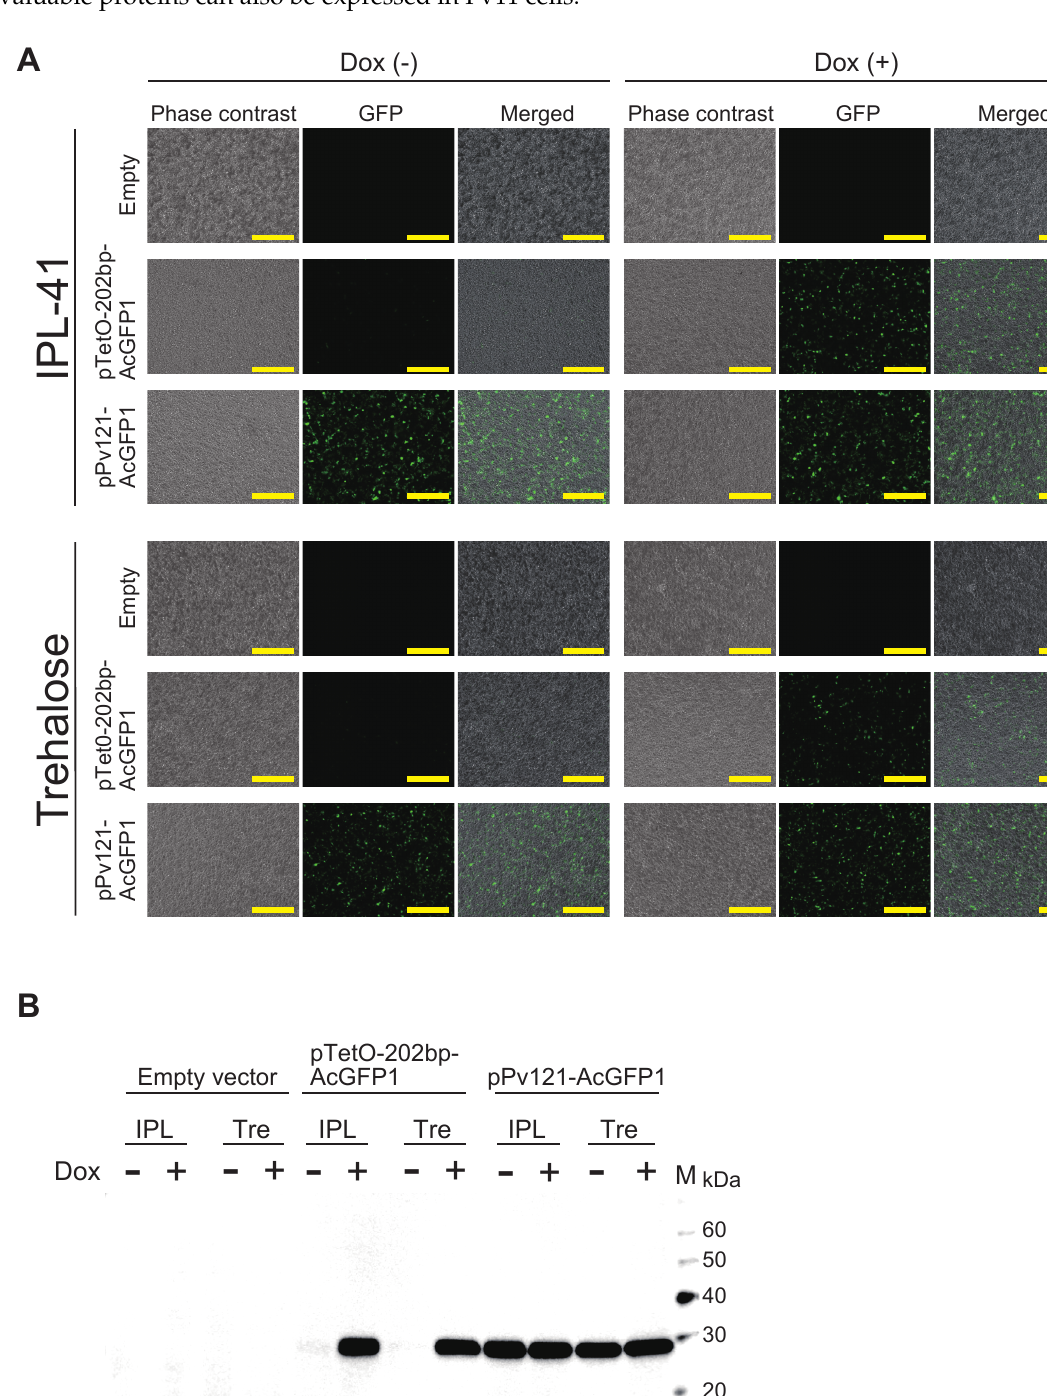
Figure 2. AcGFP1 expression using the Tet-On system in Pv11 cells. ( A ) The images of the cells were acquired using a BZ-X700 fluorescence microscope. The upper and lower images show the cells cultured in IPL-41 medium and 600 mM trehalose solution, respectively. Scale bars, 200 µ m. ( B ) Western blot analysis was performed on extracts of Pv11 cells transfected with the indicated vectors. IPL, IPL-41 medium; Tre, 600 mM trehalose solution; Lane M, protein